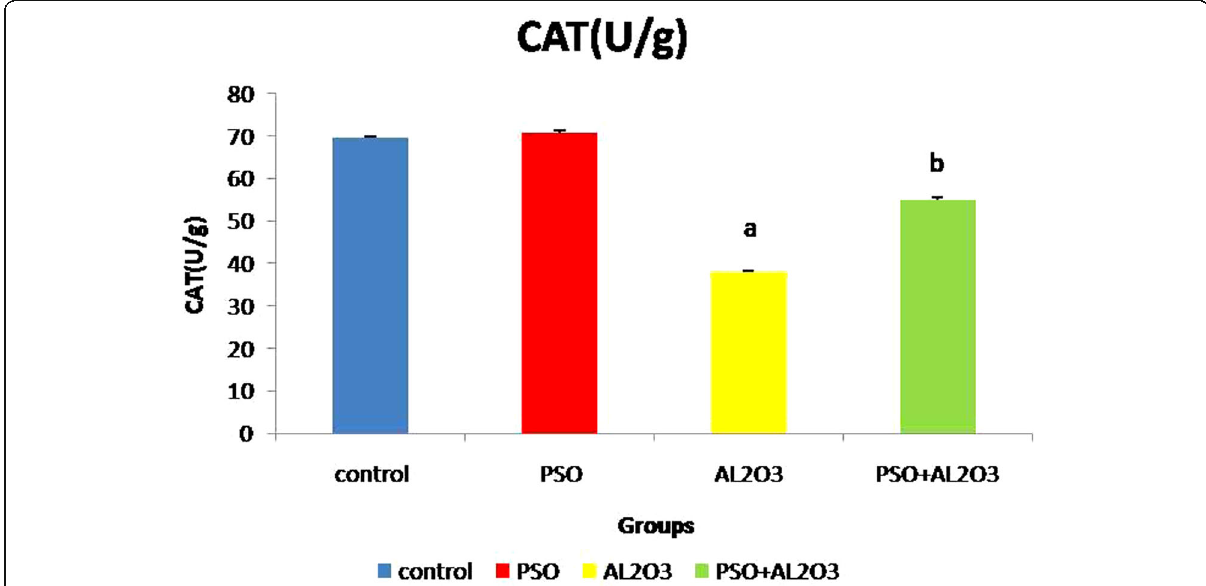
Fig. 6 Effect of pumpkin seed oil on the level of catalase (CAT), in testicular tissue of AL 2 O 3 -NP administrated rat. (a) Significant change from the control rat. (b) Significant change from the AL 2 O 3 -NP-administrated